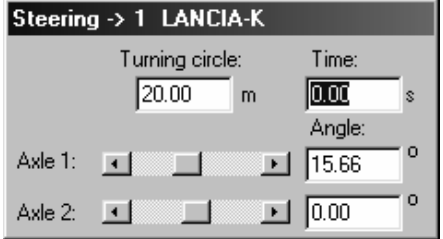
Fig 6. Insertion of the parameters of turning of the auto-